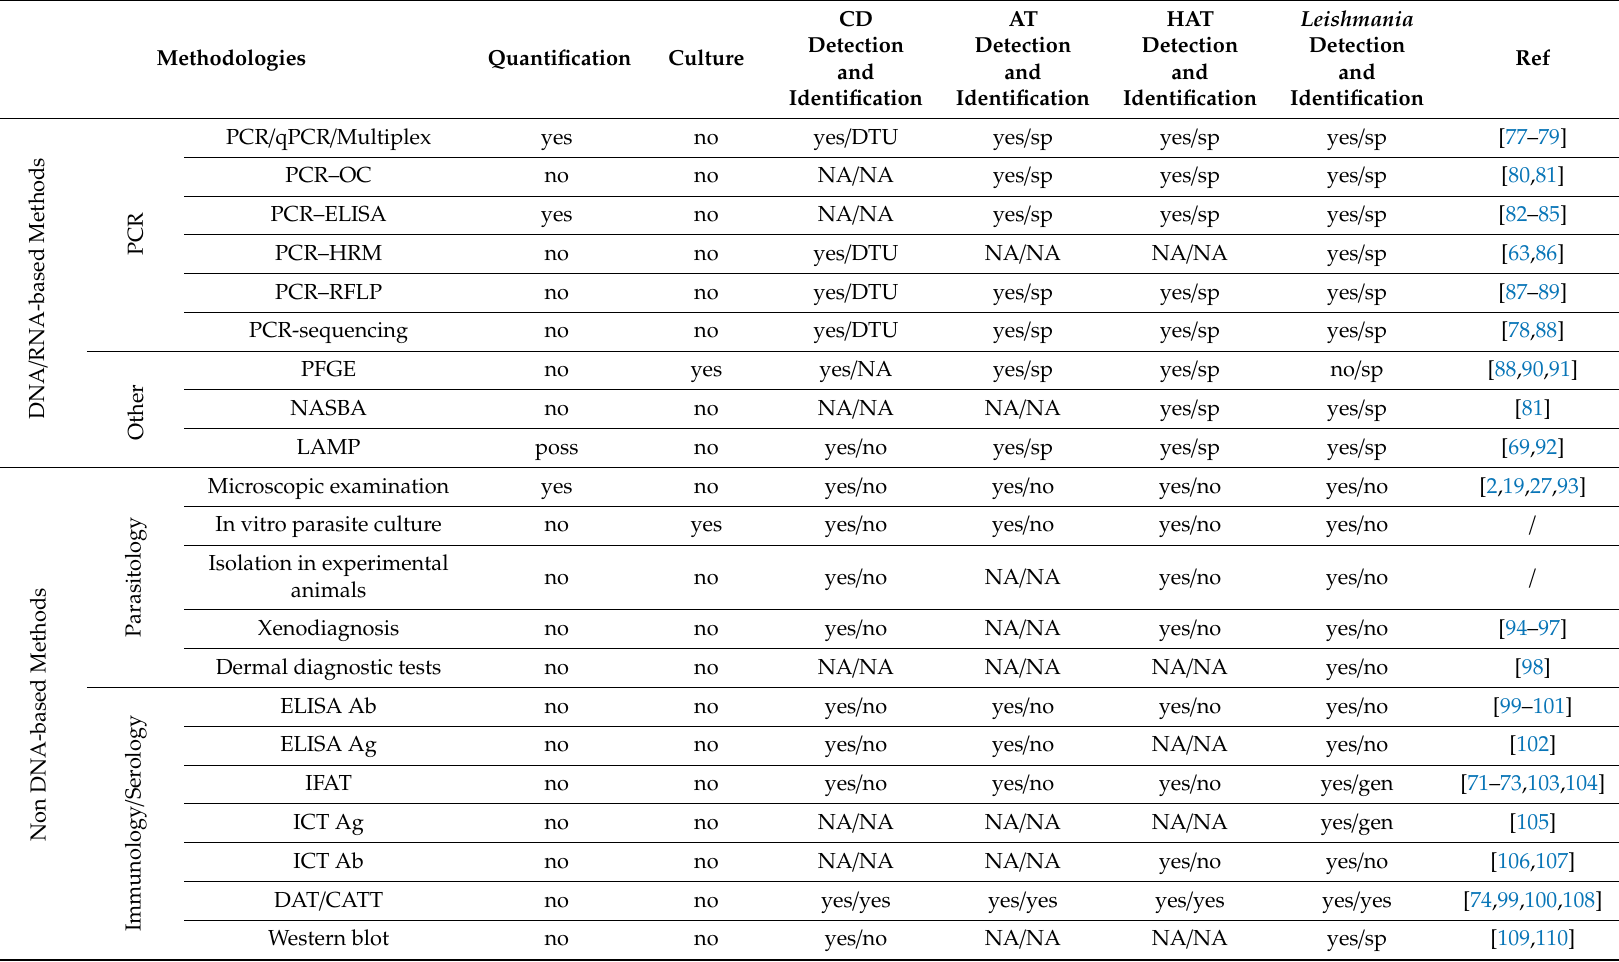
Table 1. Methodologies to diagnose Chagas disease (CD), animal trypanosomiases (AT), human African trypanosomiasis (HAT), and leishmaniosis, and / or to detect their respective causative